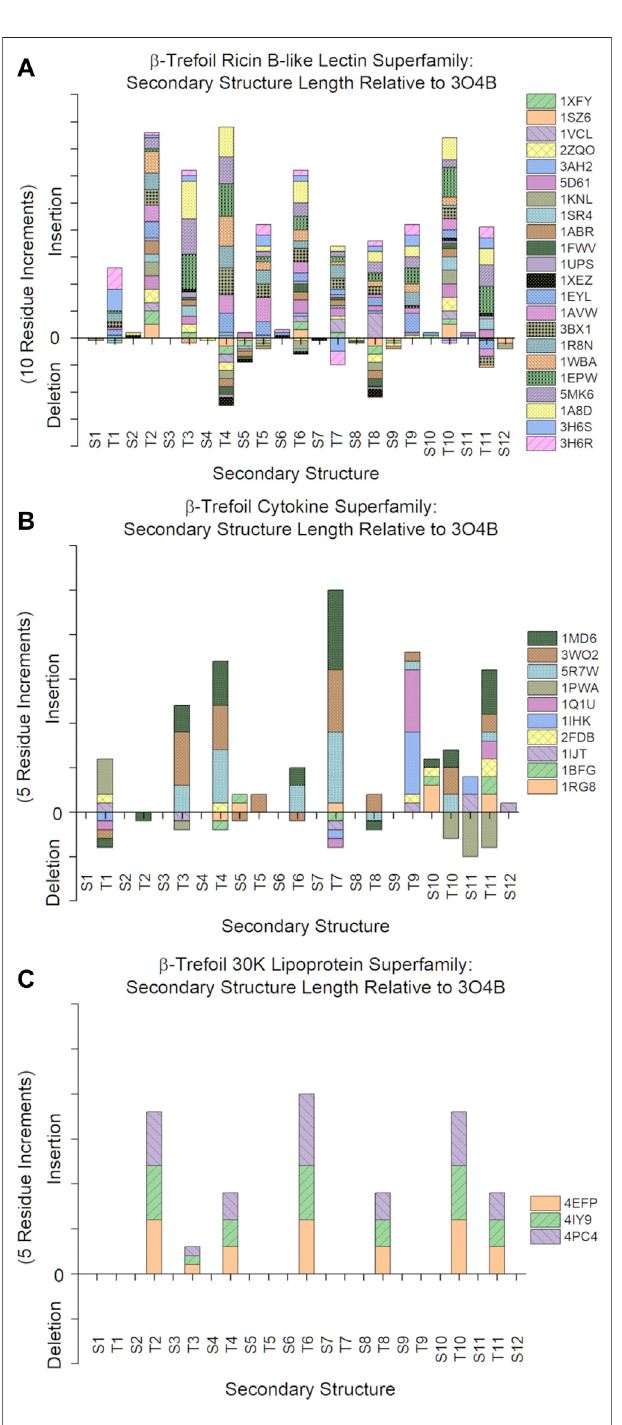
FIGURE 5 | Relative secondary structure insertions or deletions of individual β -trefoil superfamilies. (A) : Ricin B-like lectin superfamily ( n = 22). (B) : Cytokine superfamily ( n = 10). (C) : 30 K Lipoprotein superfamily ( n = 3).